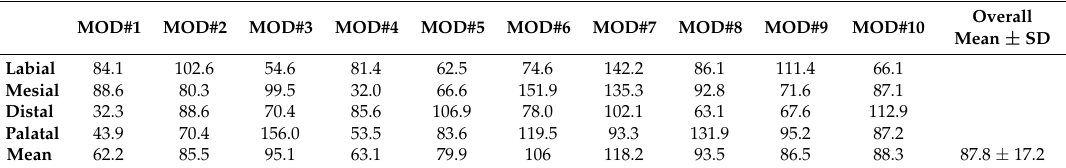
Table A3. Marginal gap ( µ m) of the immediate provisional restorations measured by replica technique. MOD, model. SD, standard deviation.